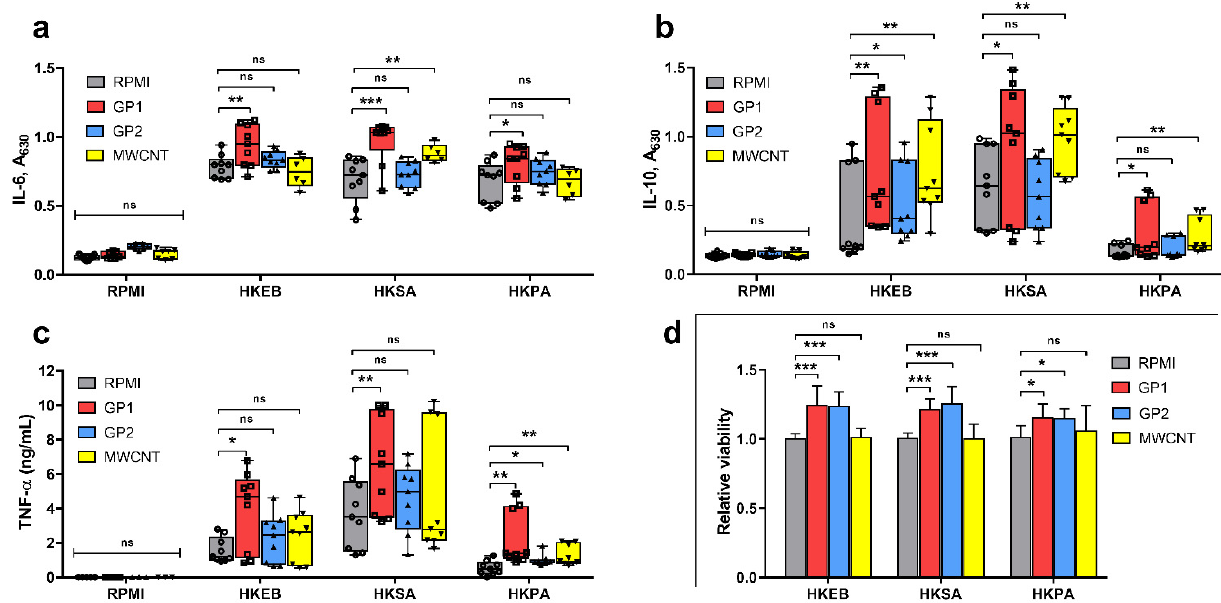
Figure 4. Cytokine response of primary monocytes to GPs (60 µ g/mL) and MWCNTs (30 µ g/mL) and heat-killed bacteria. ( a ) IL-6, ( b ) IL-10 and ( c ) TNF- α production. Cells were incubated in full RPMI and C-BNM for 24 h. After washing, cells were restimulated with HKEB, HKSA or HKPA for a further 24 h. Results were analysed separately using the paired Wilcoxon test, and data are presented as a boxplot from min to max with all points. *** p < 0.001, ** p < 0.01 and * p < 0.05, ns, not significant, highlights statistical significance as compared to corresponding control (RPMI). ( d ) Viability of monocytes after incubation with heat-killed bacteria. Data are normalised to control (RPMI) and reported as mean ± standard deviation. *** p < 0.001, * p < 0.05 highlights statistical significance as compared to corresponding control (RPMI).